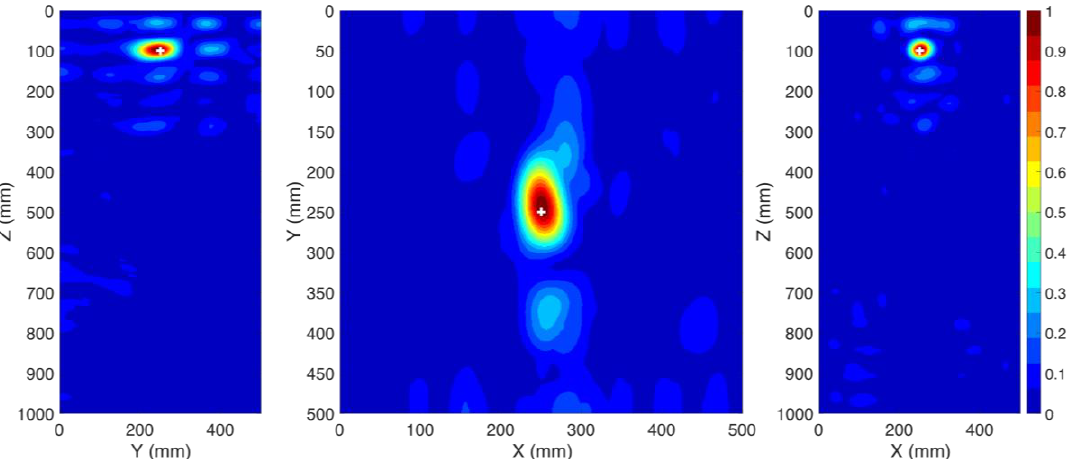
Figure 3. Normalized distribution of the maximum electric field power over the time inside the transformer tank (CS #1). The ground truth location of the PD source (PD1) is shown by the “ + ” marker. Two sensors (S1 and S2) are used.